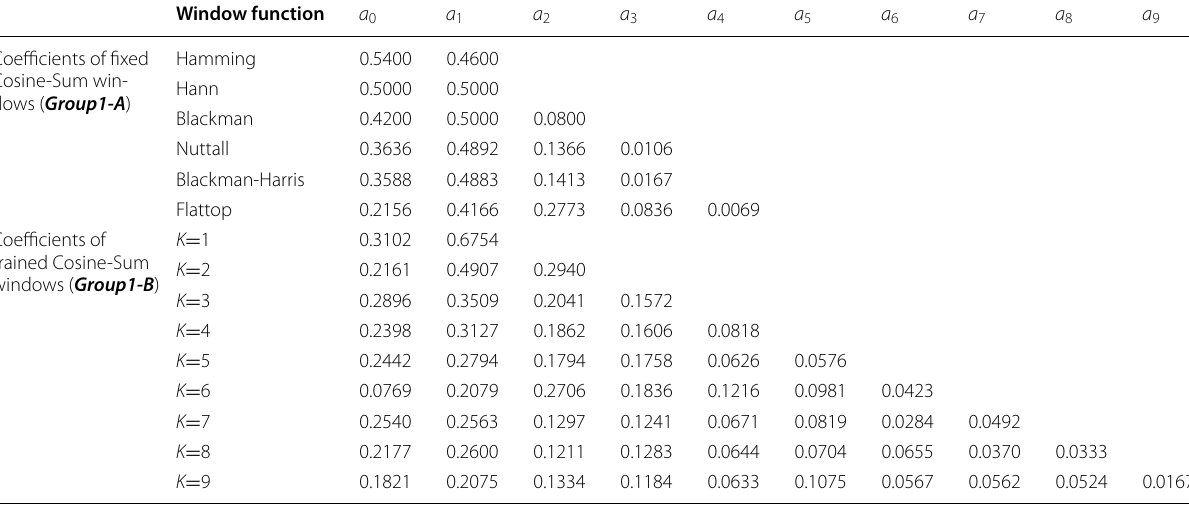
Table 2 The coefficients of Cosine-Sum windows, where K is the number of coefficients, as defined in Eq. 4 Window